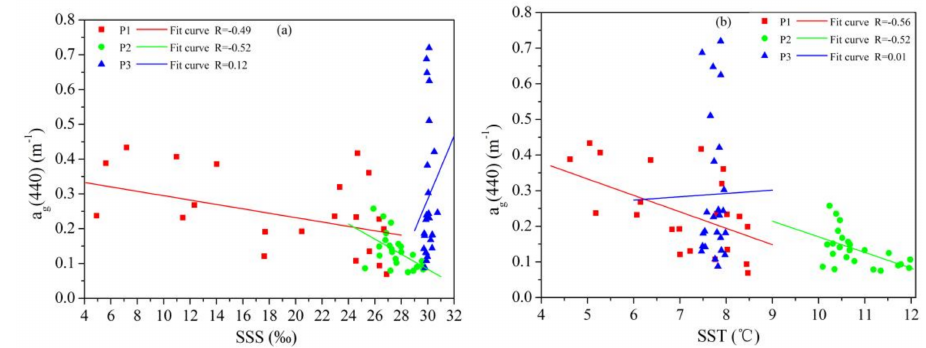
Figure 5. Relationships of: a g (440) vs. SSS ( a ); and a g (440) vs. SST ( b ), at Stations P1 (red squares, N = 21), P2 (green circles, N = 24) and P3 (blue triangles, N = 24). The solid line represents the linear regression with SSS and SST for a g (440). A general trend of decreasing CDOM with increasing SSS and SST was observed for Station P1 and Station P2, but not observed for Station